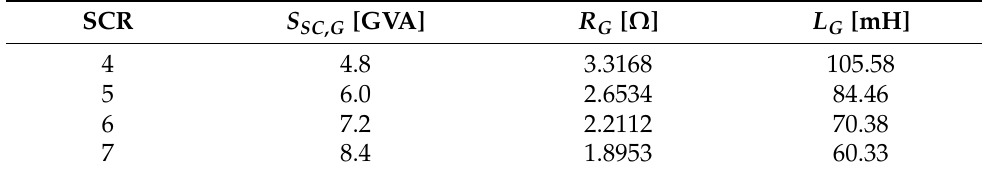
Table 2. AC grid impedance